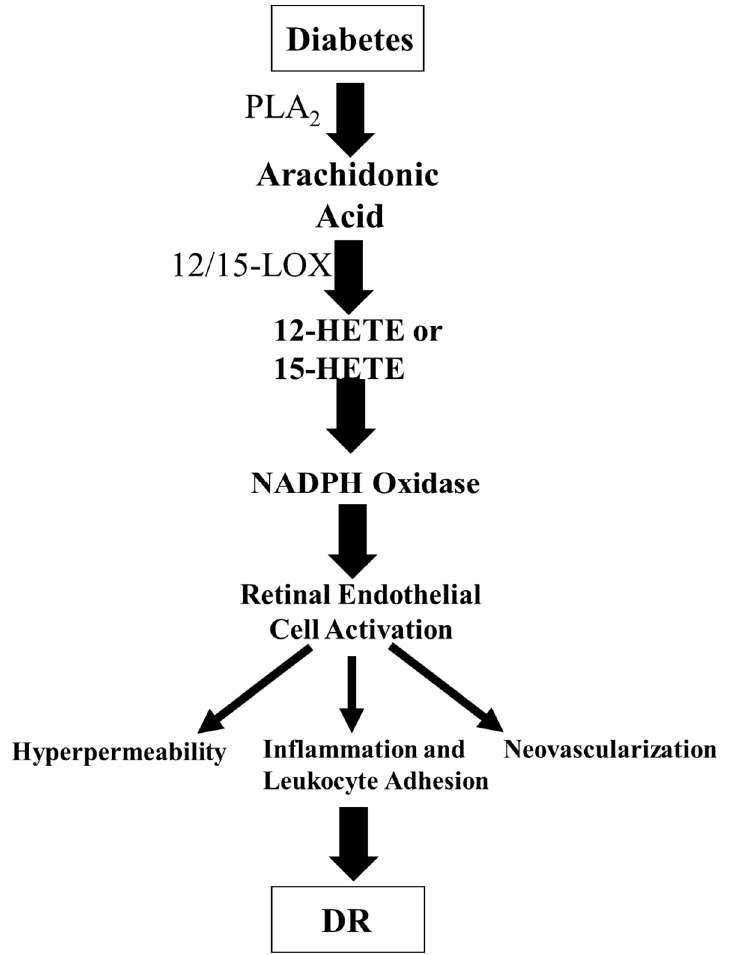
Figure 4. Cascade events involved in the pathogenesis of DR: Hyperglycemia activates the PLA2 to release AA from the retinal cell membrane. AA is converted to 12- or 15-HETE that generates ROS through NOX, creating a status of oxidative stress. This oxidative stress leads to the activation of retinal endothelial cells through various inflammatory signaling pathways, leading to leukocyte adhesion, hyperpermeability, and ultimately NV (the cardinal signs of DR).